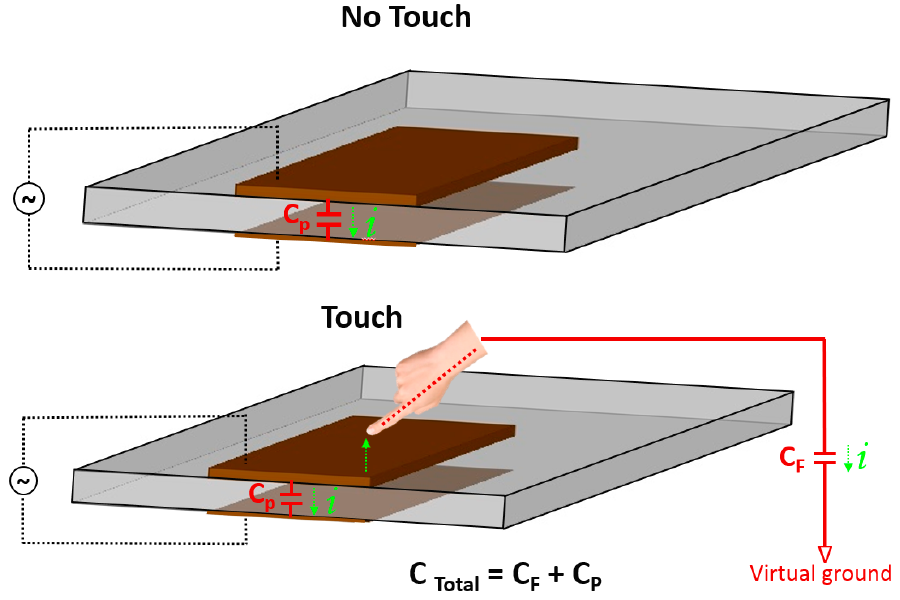
Figure 1. Principle of capacitive sensing.